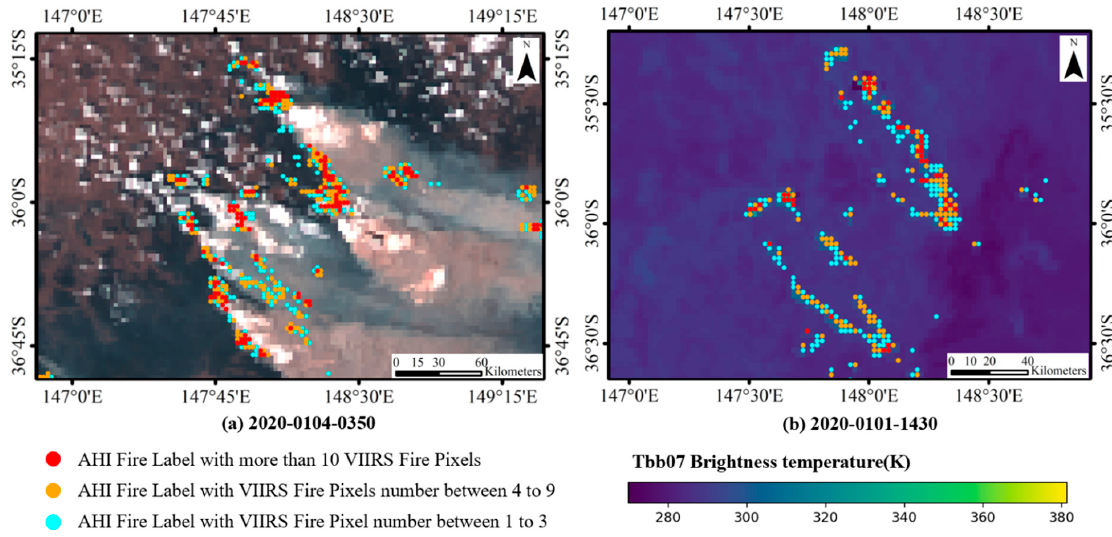
Figure 8. ( a , b ) show the spatial locations of Himawari-8 fire pixels with different fire pixel counts in sample area 1 and sample area 3, respectively.